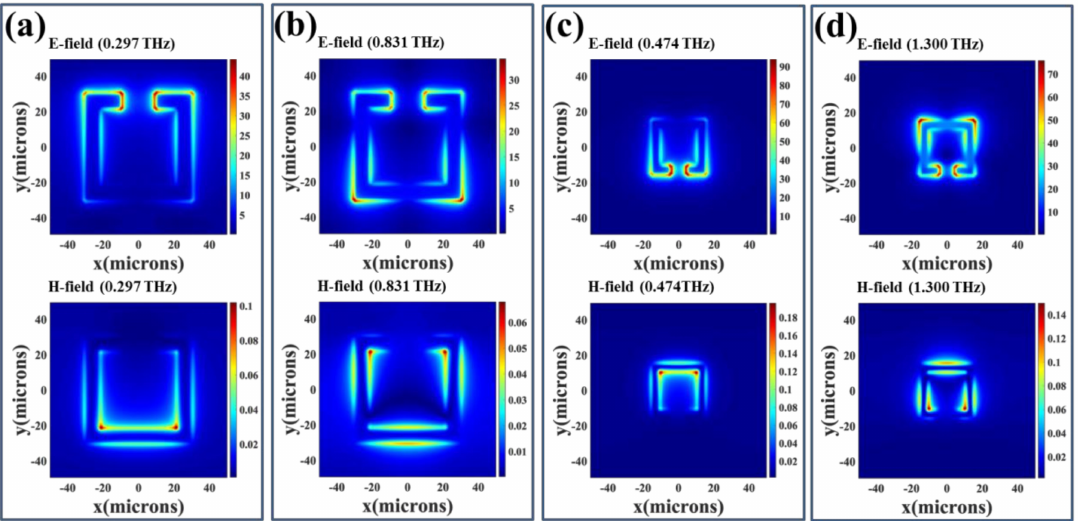
Figure 4. E- and H-field distributions of SRR-1 and SRR-2 with h = 0 µ m. They are ( a ) SRR-1 monitored at f = 0.297 THz; ( b ) SRR-1 monitored at f = 0.831 THz; ( c ) SRR-2 monitored at f = 0.474 THz and ( d ) SRR-2 monitored at f = 1.300 THz; respectively.